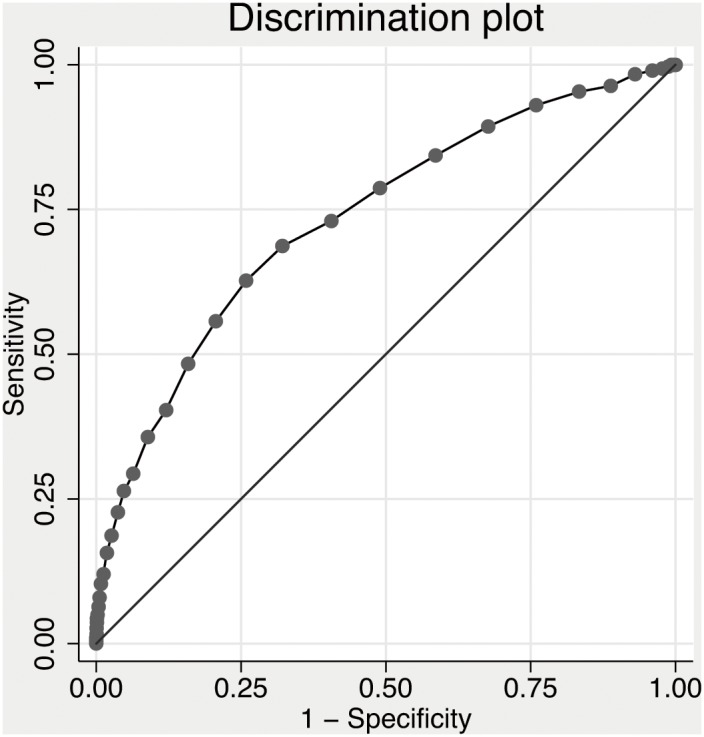
Discrimination plot of albumin as a predictor of 30-day all-cause mortality.